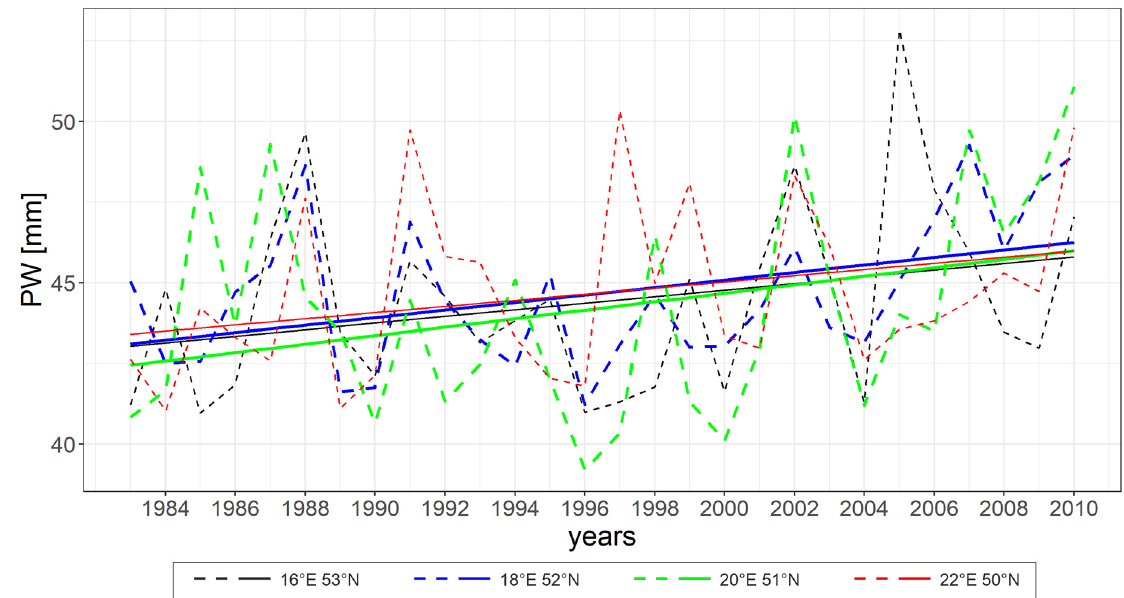
Figure 16. Annual maximum of PW (dashed lines) with trend lines (solid lines) for selected grid points from the years 1983–2010. Lines of statistically significant trends, and accordingly PW courses, are in bold.